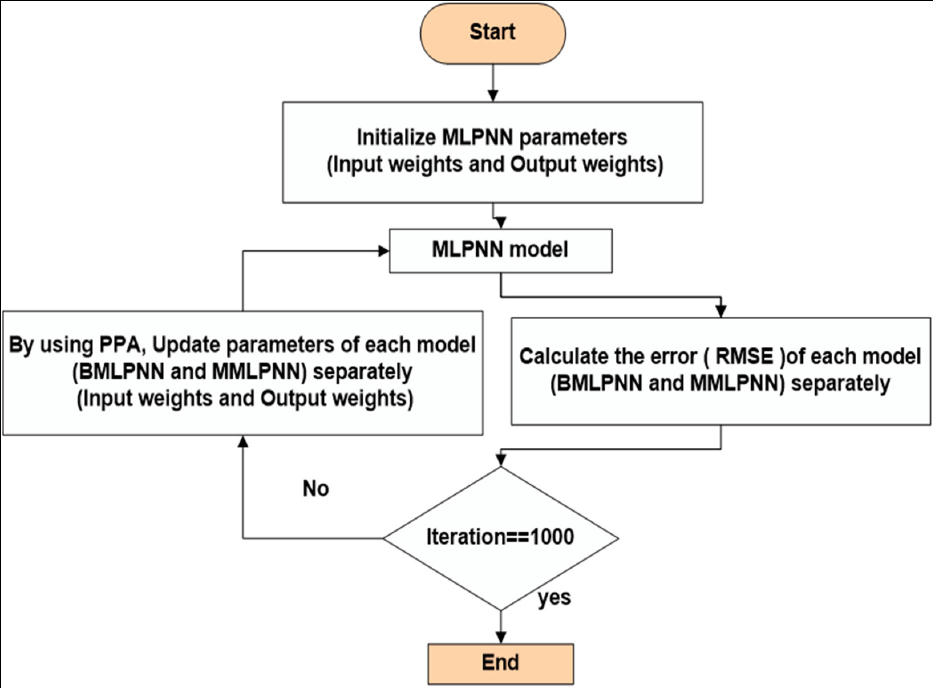
Figure 2. Training process of using prey predator algorithm (PPA) for both MLPNN models (PPA- BMLPNN and PPA-MMLPNN).